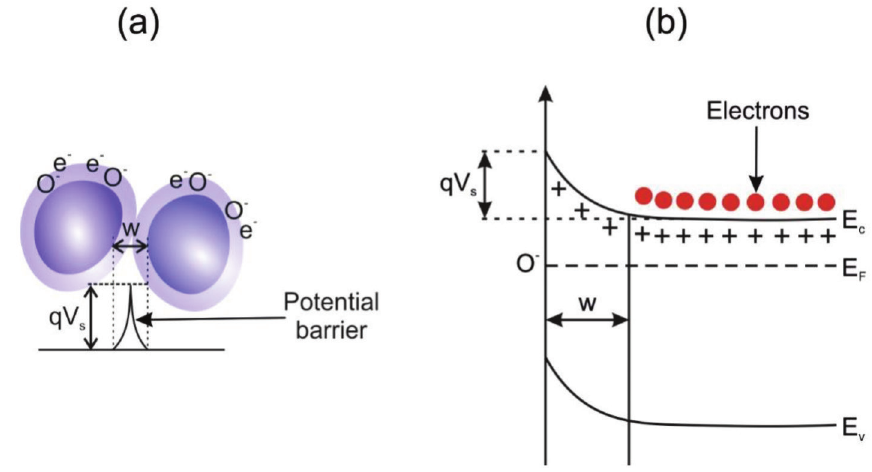
Figure 2: (a) A model showing the ionosorption of atmospheric oxygen and the formation of a potential barrier at the grain boundaries of metal oxide material. (b) The illustration of the band bending in the metal oxide structure due to the ionosorption of atmospheric oxygen on its surface, where E , E , and E are the energy of the conduction band, valence band, and the Fermi level, respectively (original C V F